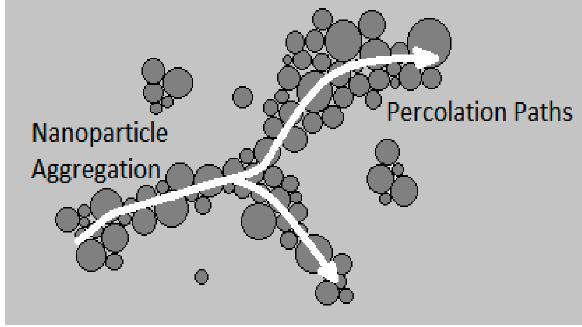
Figure 29. An illustration of randomly formed nanoparticle clusters due to particle aggregation. The white arrows show the heat percolation paths through the formed nanoparticle clusters.